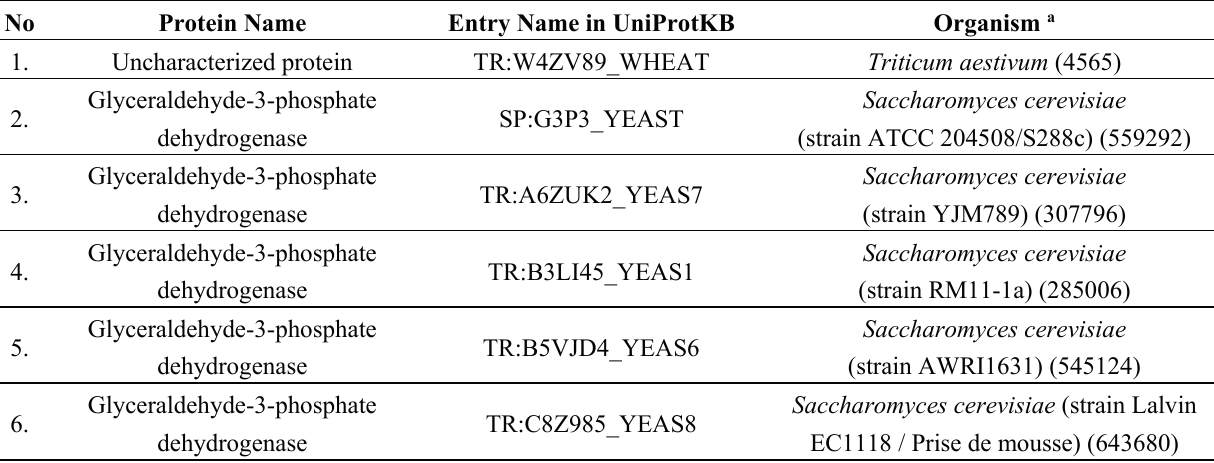
Table 3. Proteins containing fragment PANLPWGSSNV with an ACE inhibitory activity [66] (ID 49468 in the PepBank database [67,68]). The UniProt Knowledgebase [21,22] was screened with the BLAST program [69,70] with the use of the above sequence as a query and screening parameters described by Minkiewicz et al. [71]. The search was performed in May